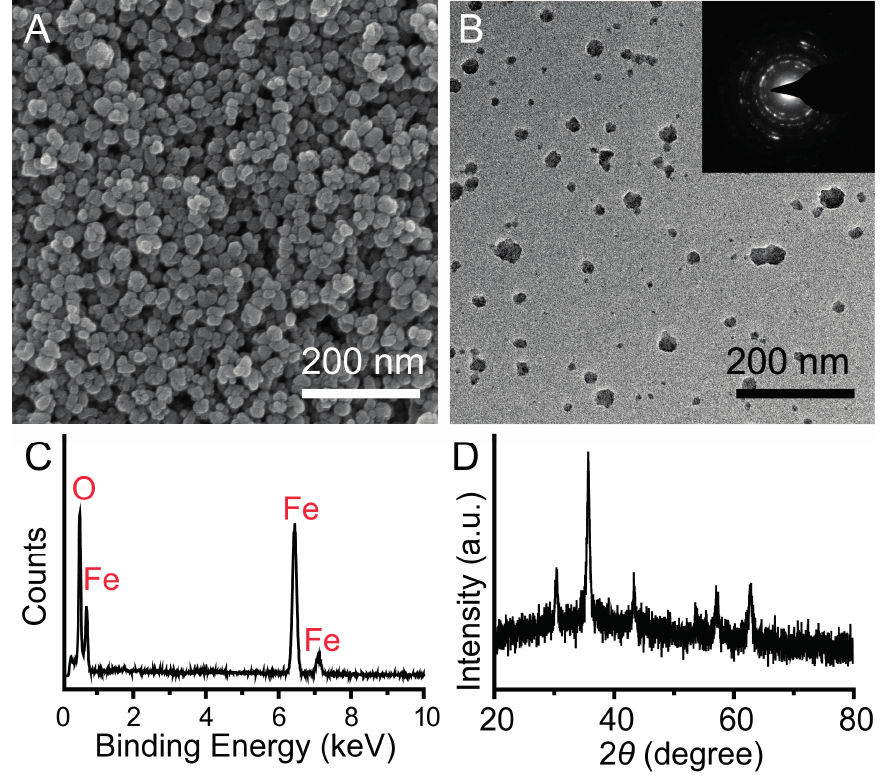
Figure 2. Scanning electron microscope (SEM) image ( A ); transmission electron microscope (TEM) image ( B ); selective area electronic diffraction (SAED) image (inset of ( B )), energy-dispersive spectroscopy (EDS) spectrum ( C ); and wide-angle X-ray diffraction (XRD) pattern ( D ) of well-prepared PEG–Fe 3 O 4